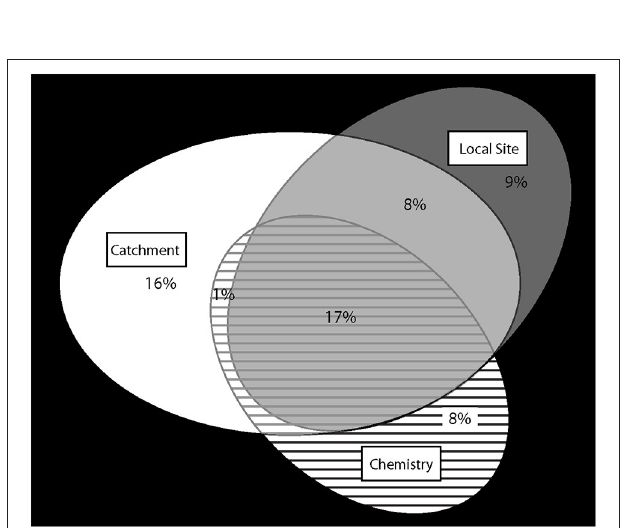
FIGURE 5 | Variance in brown trout densities as a function of different groups of environmental variables. Ellipses represent the proportion of variance explained by each group of environmental variables: whole-catchment map variables (white oval), local site physical habitat (gray oval), and stream water chemistry (hatched oval) as described in the text and shown in Figure 4 . Overlapping areas represent shared variance which cannot be statistically differentiated from among the different predictor groups. In total, 57% of the among-site variance in brown trout densities can be explained by the environmental variables, while 43% remains unexplained (black area outside the